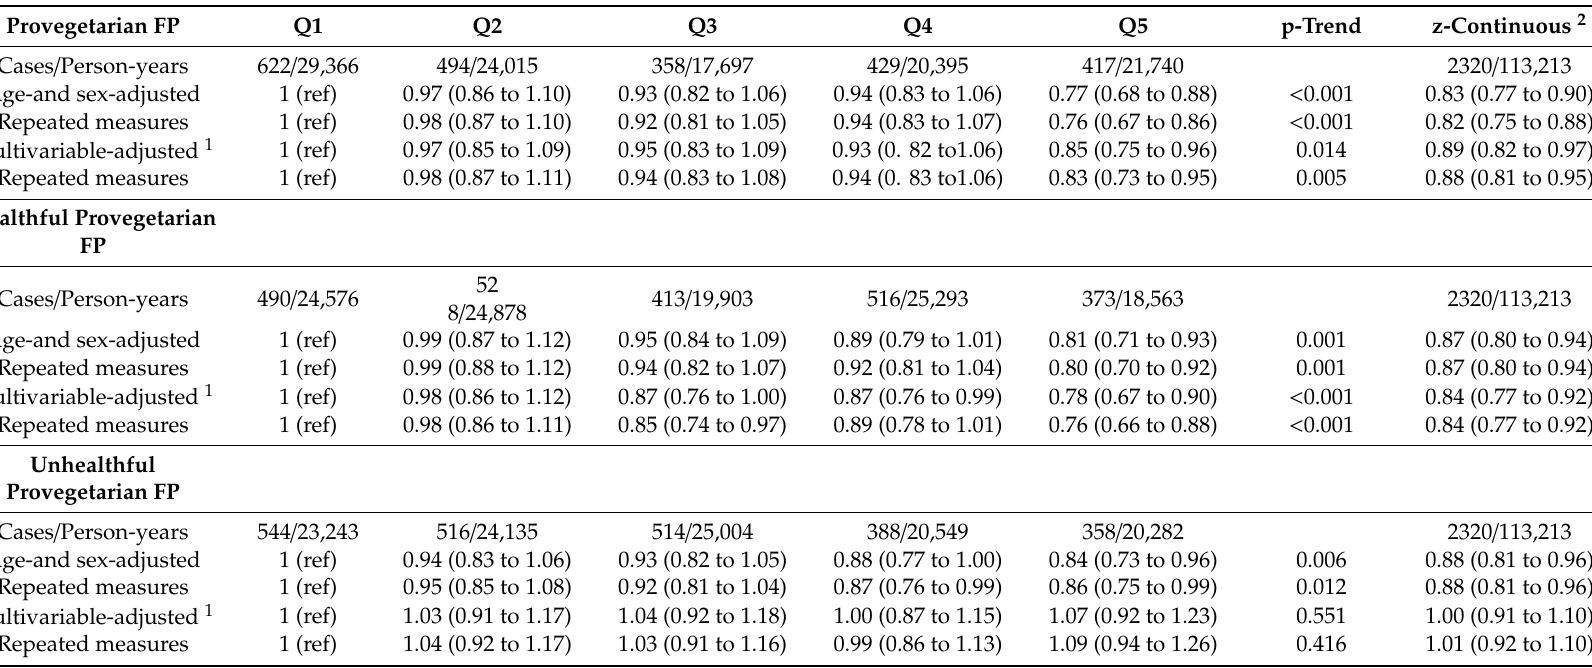
Table 2. Risk of overweight / obesity (HR and 95% CI) 1 according to quintiles (Q) of di ff erent provegetarian food patterns